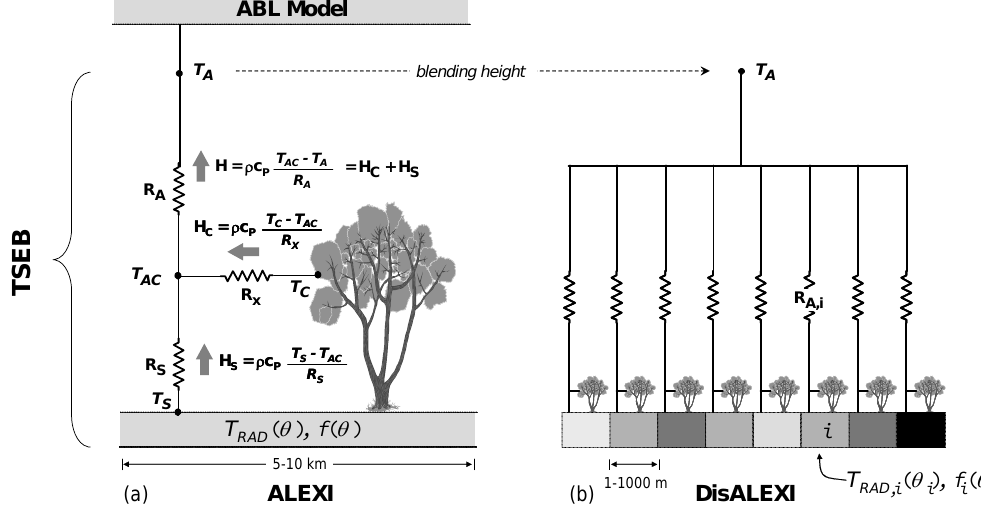
Fig. 1. Schematic diagram representing the ALEXI (a) and DisALEXI (b) modeling schemes, highlighting fluxes of sensible heat ( H) from the soil and canopy (subscripts “s” and “c”) along gradients in temperature ( T ) , and regulated by transport resistances R A (aerodynamic), R X (bulk leaf boundary layer) and R S (soil surface boundary layer). DisALEXI uses the air temperature predicted by ALEXI near the blending height ( T A ) to disaggregate 10-km ALEXI fluxes, given vegetation cover ( f (θ) ) and directional surface radiometric temperature ( T RAD ( θ) ) information derived from high-resolution remote-sensing imagery at look angle θ